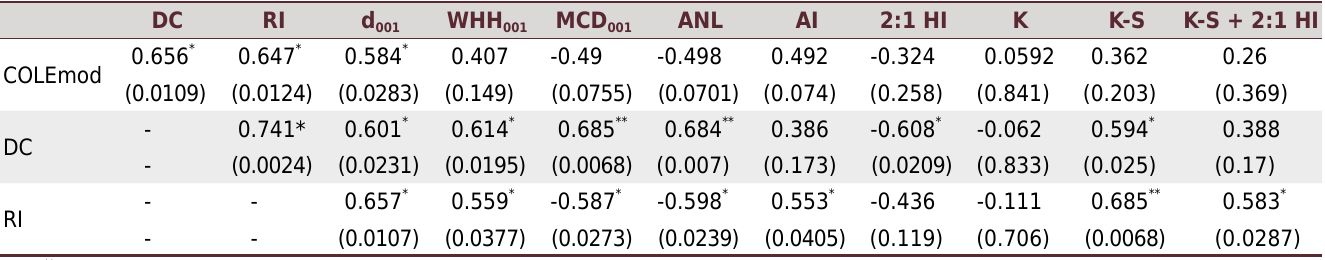
Table 7. Pearson correlations between the expansive index of modified COLE (COLEmod), Degree of Contraction (DC), and Shrinkage Index (RI) with crystallographic parameters of “kaolinite” (d 001 , WHH 001 , MCD 001 , ANL, and AI) and with the quantities of each clay mineral, semi quantified (g kg -1 ) based on the amount of clay in each